Question: What does this figure show? Answer in one sentence.
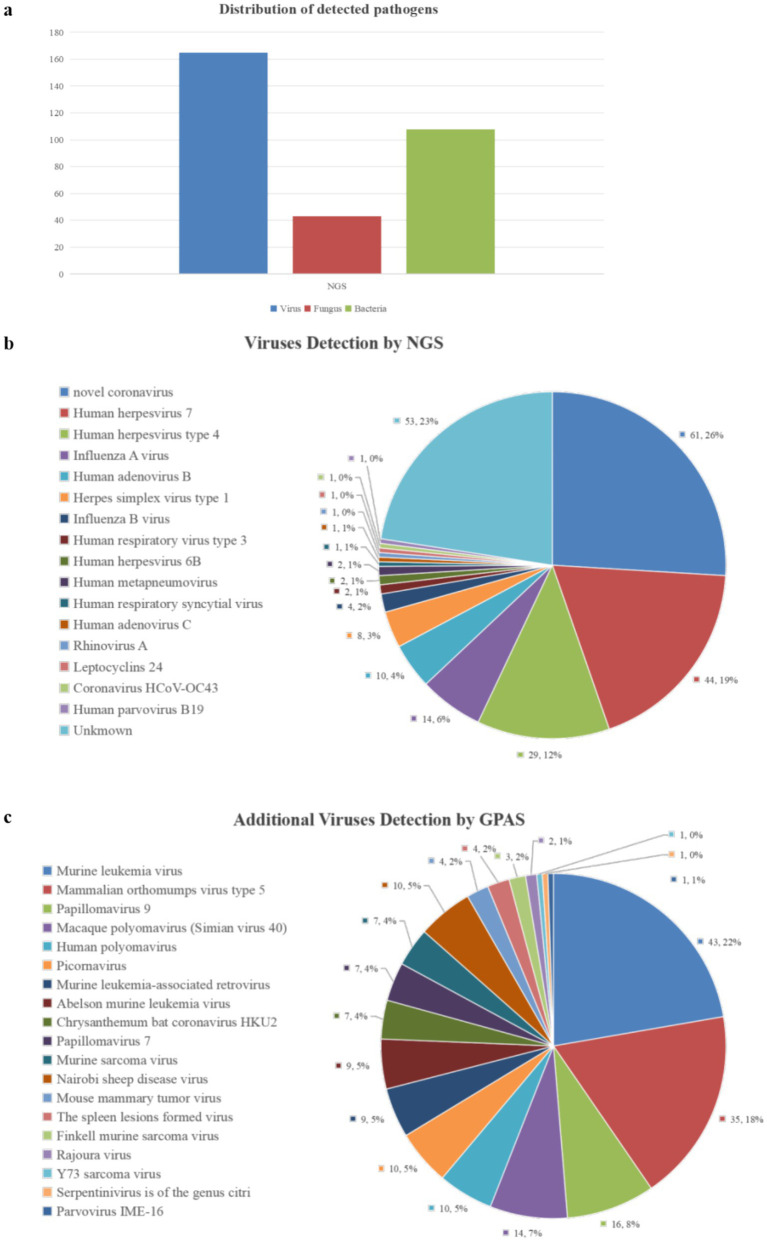
Answer: Taxonomic annotation of pathogens species. Classification and proportion of pathogens detected by different methods. (a) The number of cases of viral, fungal, and bacterial infection among the 218 patients; (b) The proportion of viruses detected by NGS; (c) The proportion of other viruses detected by GPAS.